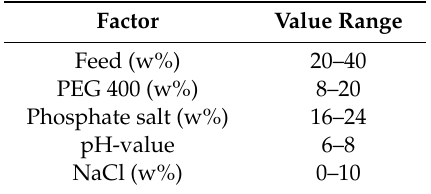
Table 3. Factor and value range used for the DoE. DoE: design of